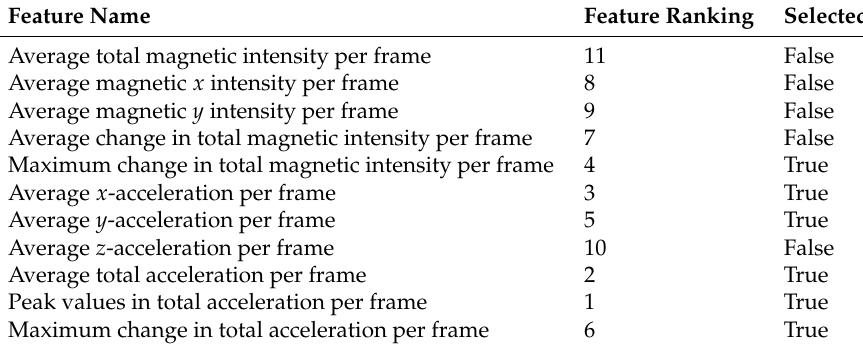
Table 2. Features’ ranking using RFE.